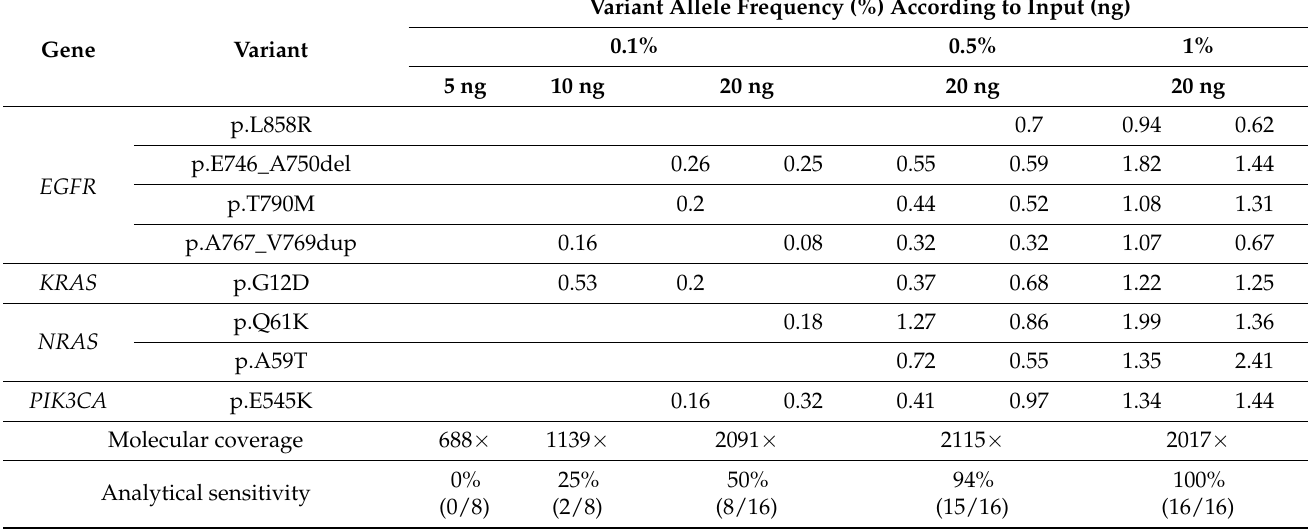
Table 1. Analytical sensitivity using the reference